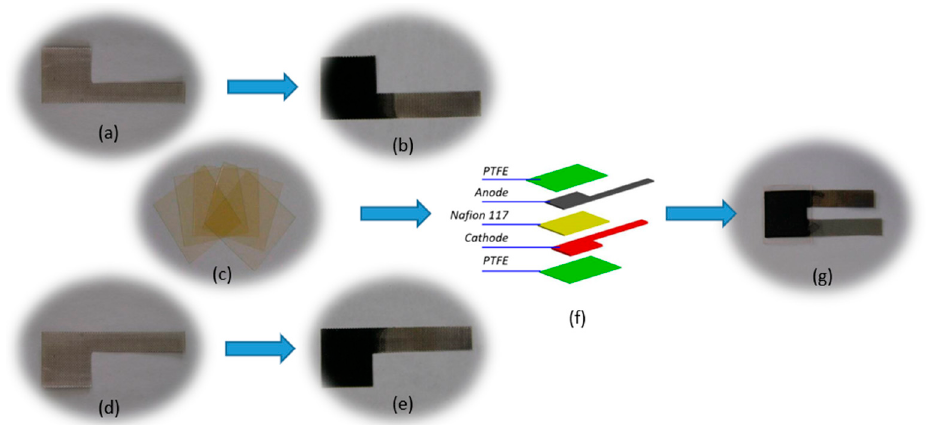
Figure 2. MEA main preparation process photo. ( a ) Titanium mesh substrate; ( b ) titanium